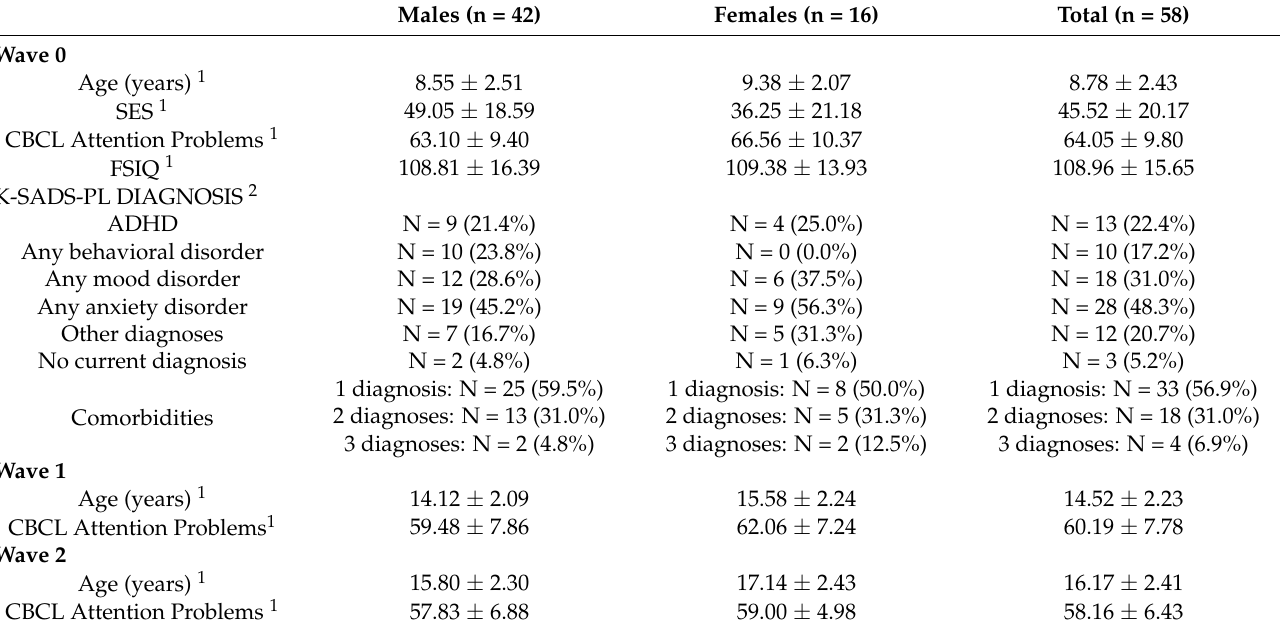
Table 1. Sociodemographic, clinical and cognitive characteristics of the sample. Males (n = 42) Females (n = 16) Total (n =